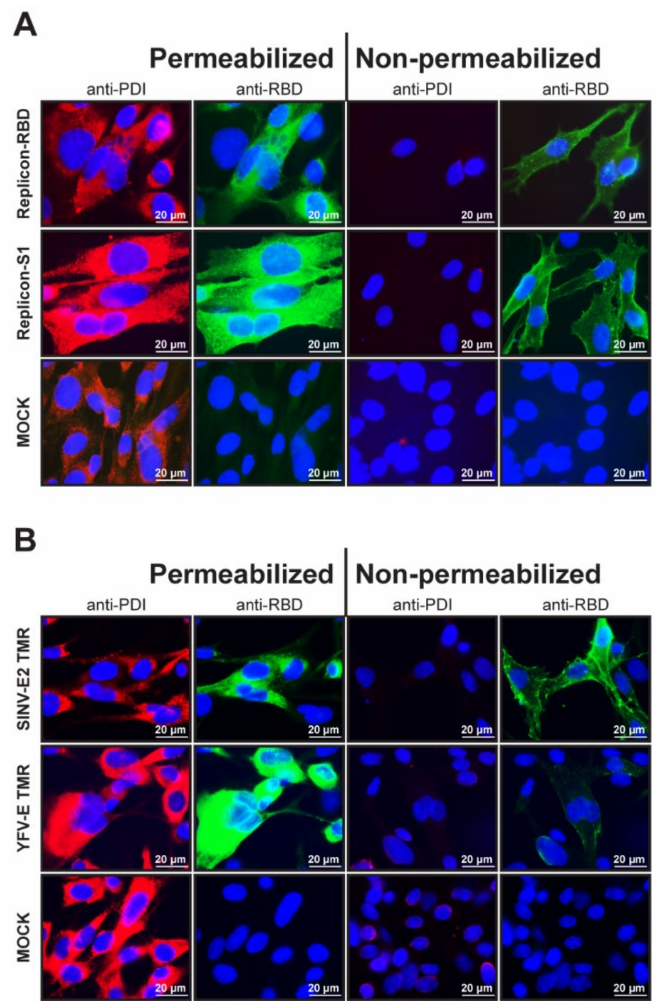
Figure 2. Immunofluorescent images of cells containing YF-replicons that express domains of the MERS-CoV S protein. Cells were either permeabilized with Triton X-100 for intracellular staining or left untreated for surface staining. ( A ) Surface and intracellular expression of the foreign domains RBD or S1. Cells were costained for protein disulfide isomerase (PDI) and MERS-CoV spike RBD. ( B ) Surface and intracellular expression of the RBD domain of MERS-CoV spike protein fused to either the SINV E2 TMR or the authentic YFV-E TMR in cells. Cells were costained for PDI. ( A , B ) PDI is stained red and RBD, green, and cell nuclei are visualized with DAPI staining (blue). A 63 × objective (with immersion) was used to obtain the